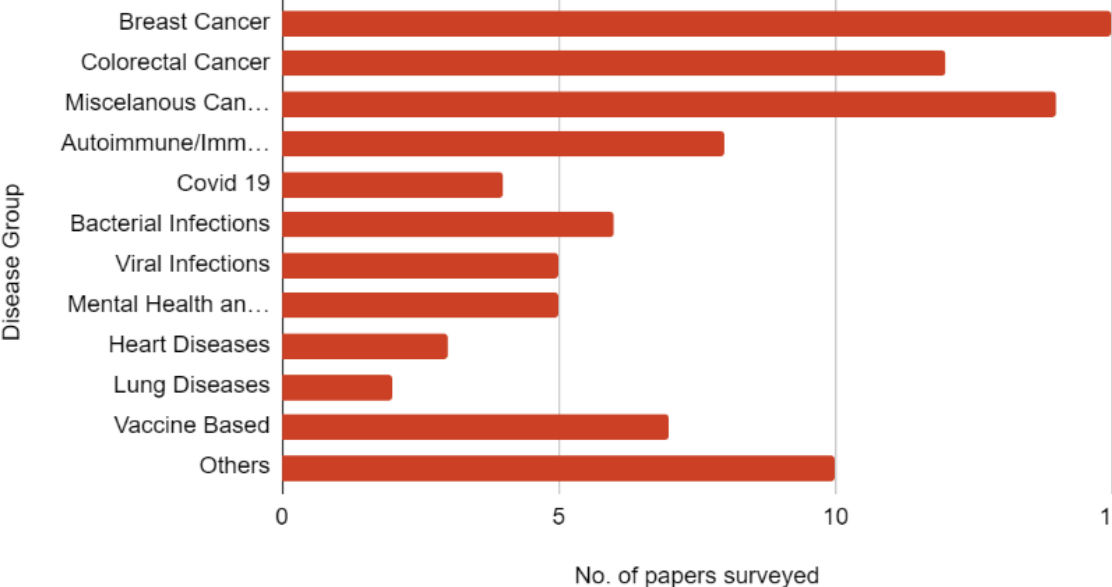
Figure 13. The bar chart representation of the distribution of literature of various immunology subdomains. Table 4. A list of datasets applied to